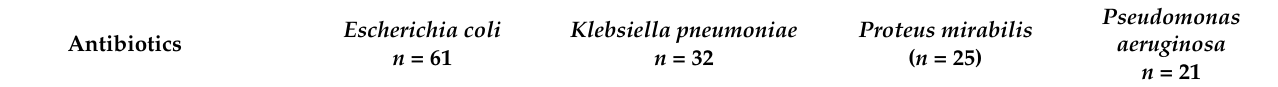
Table 2. Drug susceptibility of the most common etiological factors of UTIs in the Clinical Department of Orthopedic, Traumatic, Oncological, and Reconstructive Surgery in 2013–2015. Antibiotics